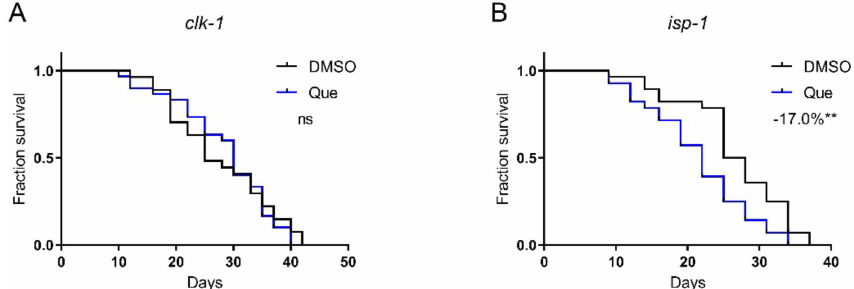
Figure 6. Quetiapine-induced lifespan reduction is associated with mitochondrial function. Survival curves of mutant clk-1 ( n = 30 worms per group) ( A ) and isp-1 ( n = 30 worms per group) ( B ) treated with 100 µ M of quetiapine or DMSO at 20 ◦ C. Data were analyzed by using log-rank test (ns: no significant difference with p > 0.05; **: p <